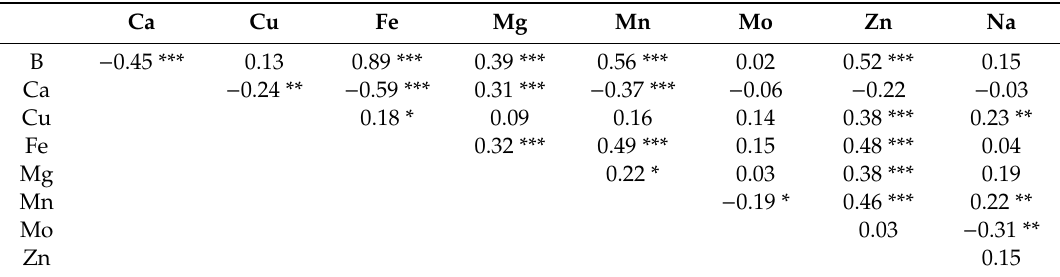
Table S1 in SI for details); BR: province of Brindisi; LE: province of Lecce; TA: province of Taranto. Table 2. Pearson correlation matrix among the variables for soil samples. *, **, *** indicate significance at p < 0.05, p < 0.01 and p < 0.001, respectively.